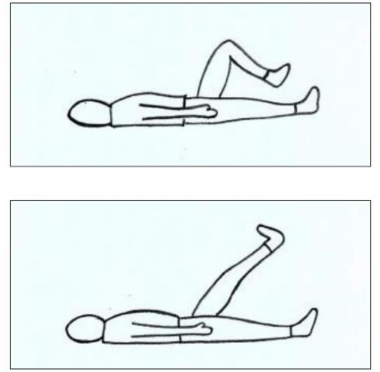
Figure 4. Schematic representation of passive